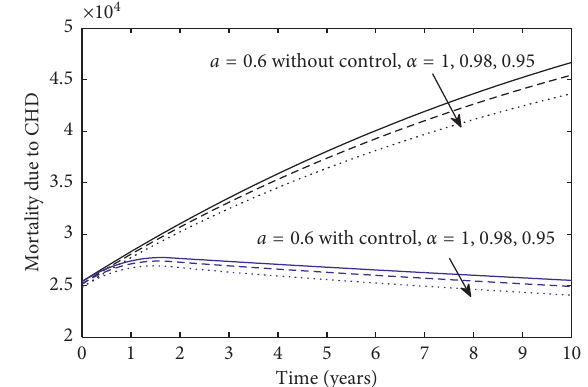
Figure 5: Mortality due to CHD, where a � 0 . 6 without control (black lines) and with control (blue lines) for α � 1 (solid line), α � 0 . 98 (dashed line), and α � 0 . 95 (dotted